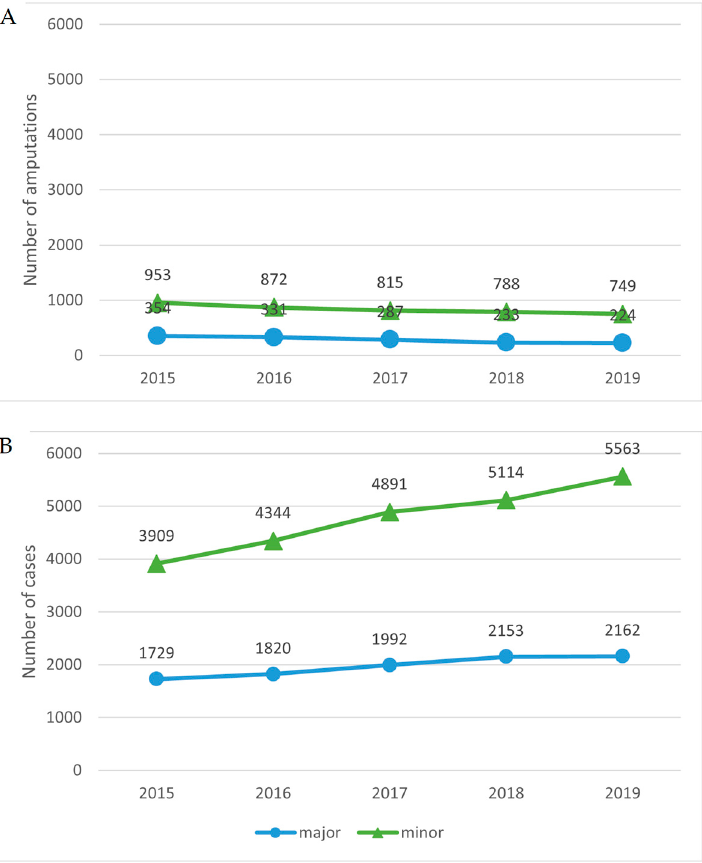
Figure 2. Trends in the number of major and minor lower extremity amputations in patients with T1DM ( A ) and T2DM ( B ). T1DM, type 1 diabetes mellitus; T2DM, type 2 diabetes mellitus. Men had a higher frequency of lower extremity amputations than women, regardless of whether they had T1DM or T2DM (Figure 3). Variations in the numbers of amputations compared with the baseline (2015) followed a decreasing trend in patients with T1DM, both in women ( − 4.1%, − 9.5%, − 29.7% and − 35.1% for 2016, 2017, 2018 and 2019, respec- tively) and in men ( − 9.6%, − 18.3%, − 18.5% and − 21.5% for 2016, 2017, 2018 and 2019, re-